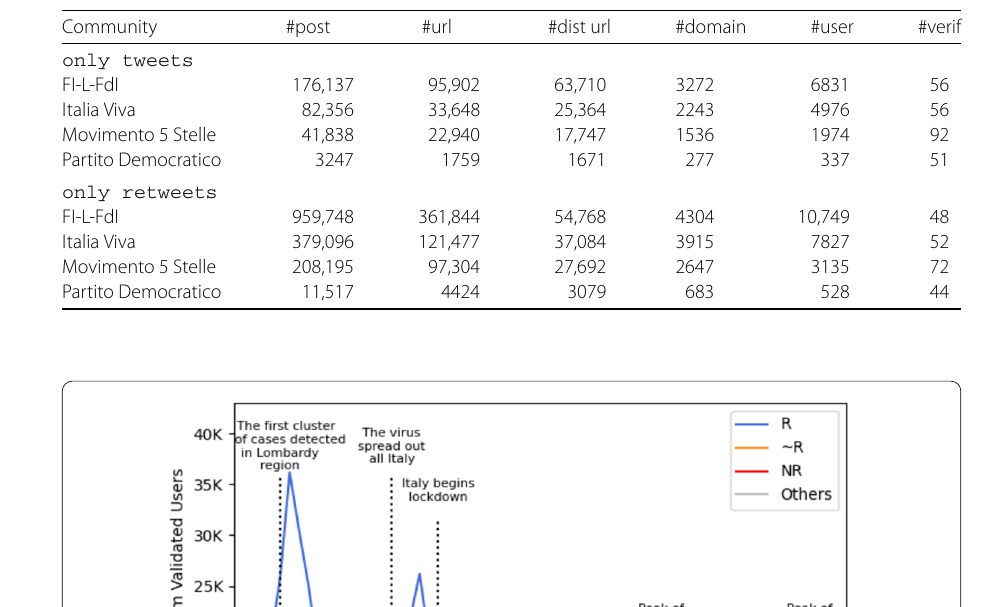
Table 5 Posts, urls, domains and users statistics per political subcommunities – directed validated network. Differently from the case of verified users, the number of tweets is nearly one fifth of the number of